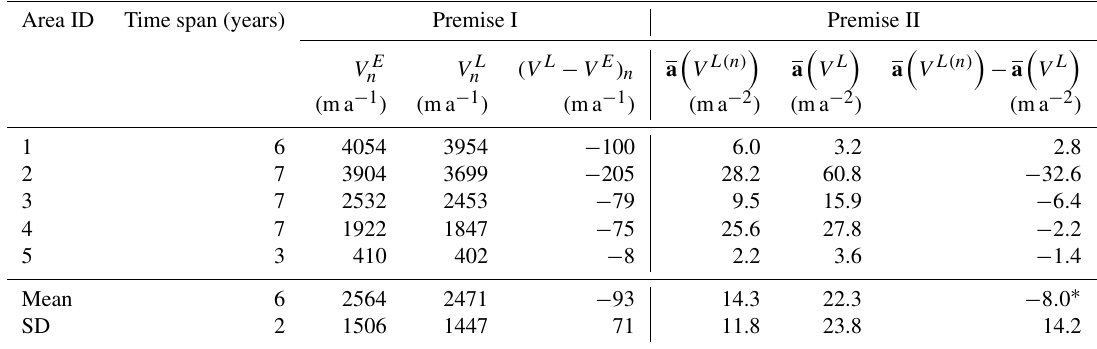
Table A4. Application of the OE correction method in five selected areas in PIG. Premise I contains n -year tracked E velocities and L velocities computed from the 3-month velocity map, as well as their differences. Premise II illustrates averaged L accelerations computed from the n -year and 3-month velocity maps, respectively, as well as their